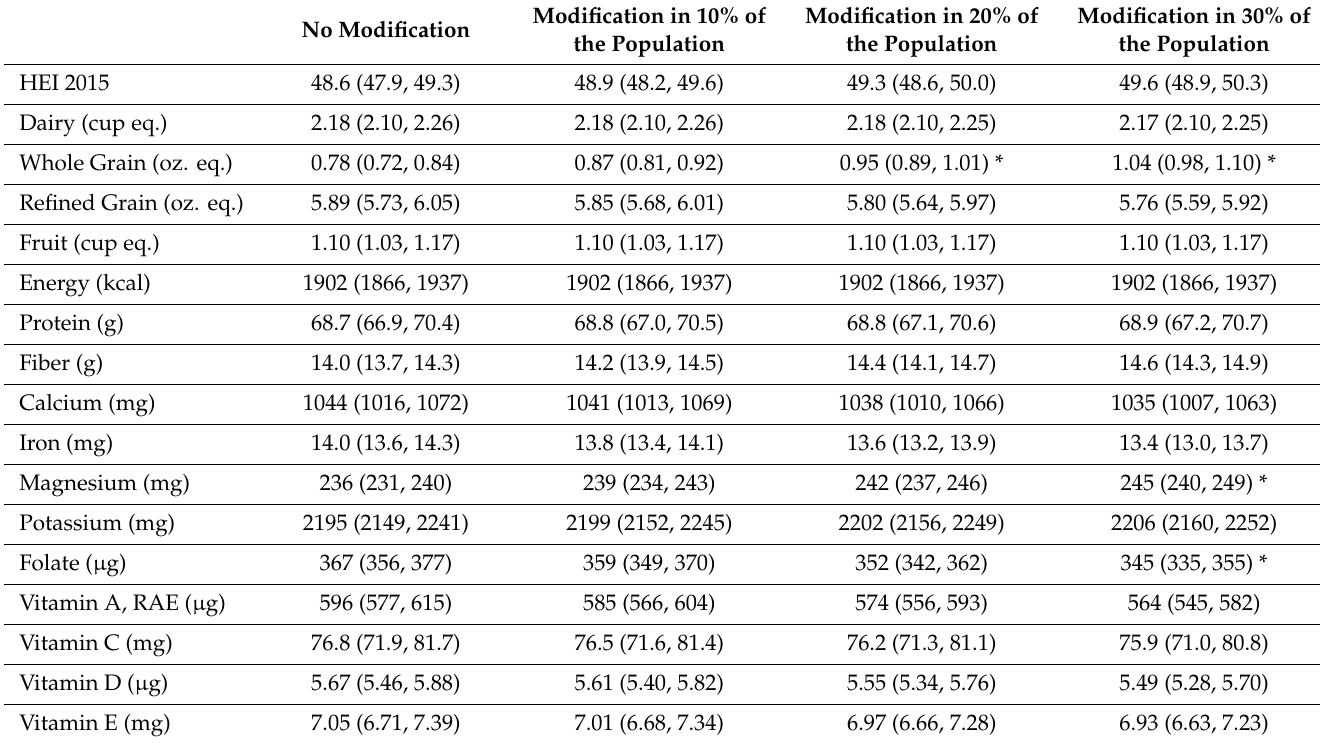
Table 4. E ff ects of replacing other breakfasts with oatmeal on diet quality and on the intake of select food groups and nutrients among children 2–18 years of age (gender-combined), NHANES